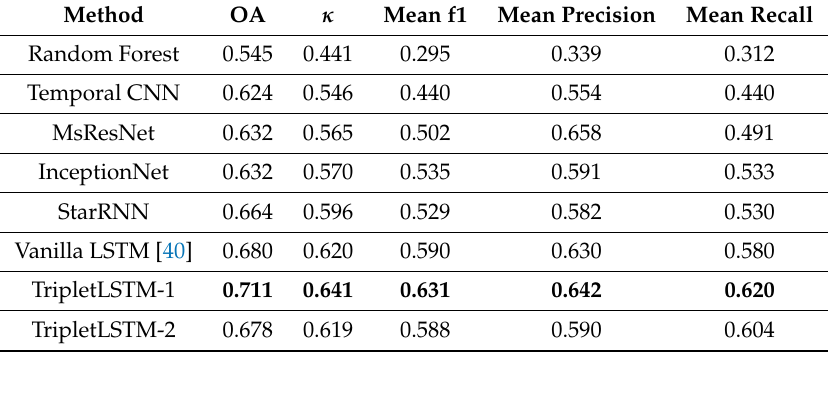
Table 2. Classification performance of the various tested approaches.